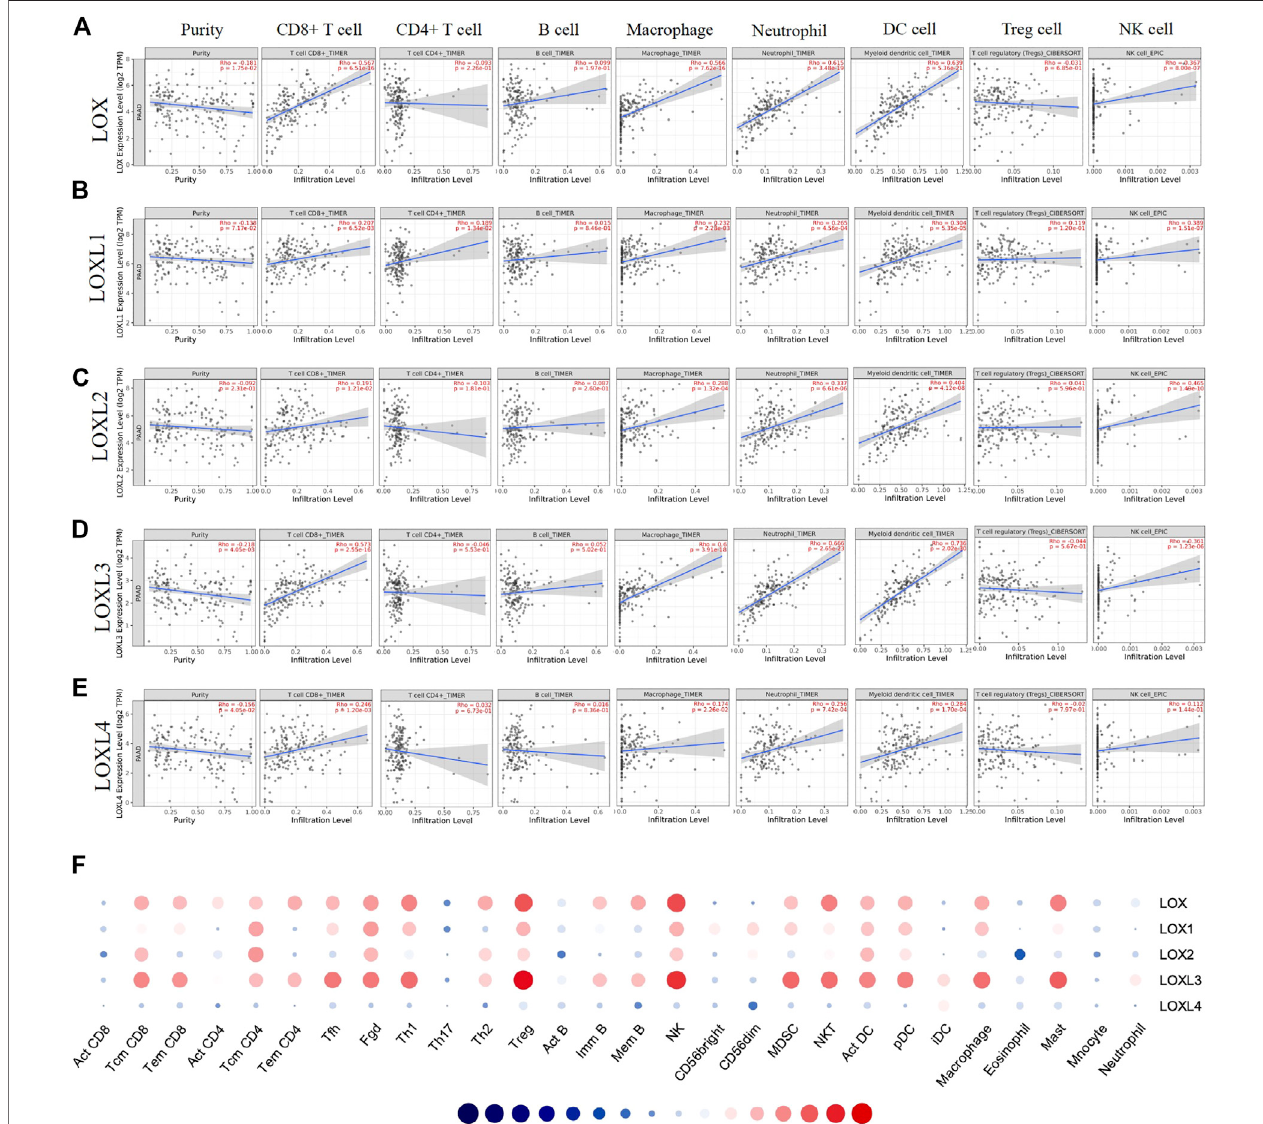
FIGURE 10 | Correlation analysis of LOXs expression and immune in fi ltration in TME of PDAC. (A – E) (TIMER). The correlation between the abundance of immune cells and the expression of (A) LOX, (B) LOXL1, (C) LOXL2, (D) LOXL3, (E) LOXL4 in PDAC. (F) Correlation between the relative abundances of 28 tumor-in fi ltrating lymphocytes (TILs) and LOXs expression in PDAC